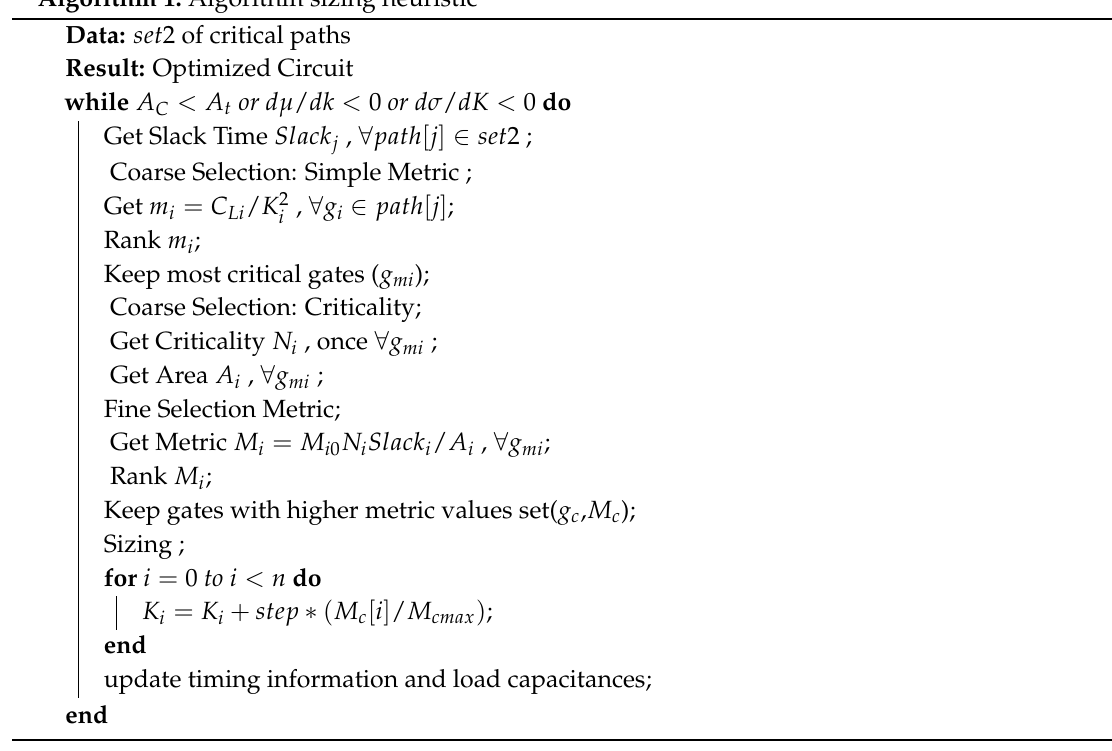
Algorithm 1: Algorithm sizing heuristic Data: set 2 of critical paths